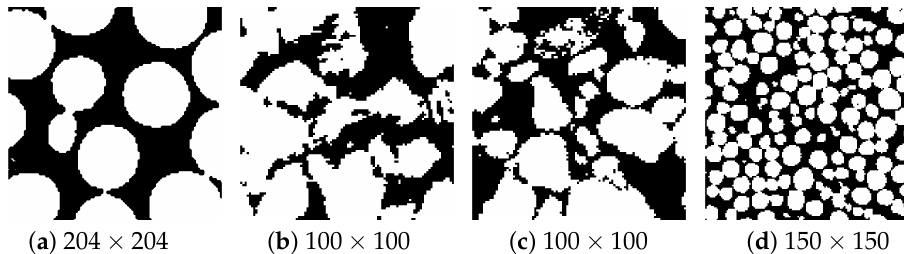
Figure 1. Different pore-scale domains without obstructions: D v = D f in black, and D r in white, with resolution as shown. From left to right: one slice of µ -CT data processed in [6–8], respectively, for ( a ) synthetic porous media (glass beads), ( b ) sandstone, ( c ) unconsolidated sand, and ( d ) proppant. Data courtesy of D. Wildenschild, B. Lindquist, A. Trykozko, and M. Dohnalik; see